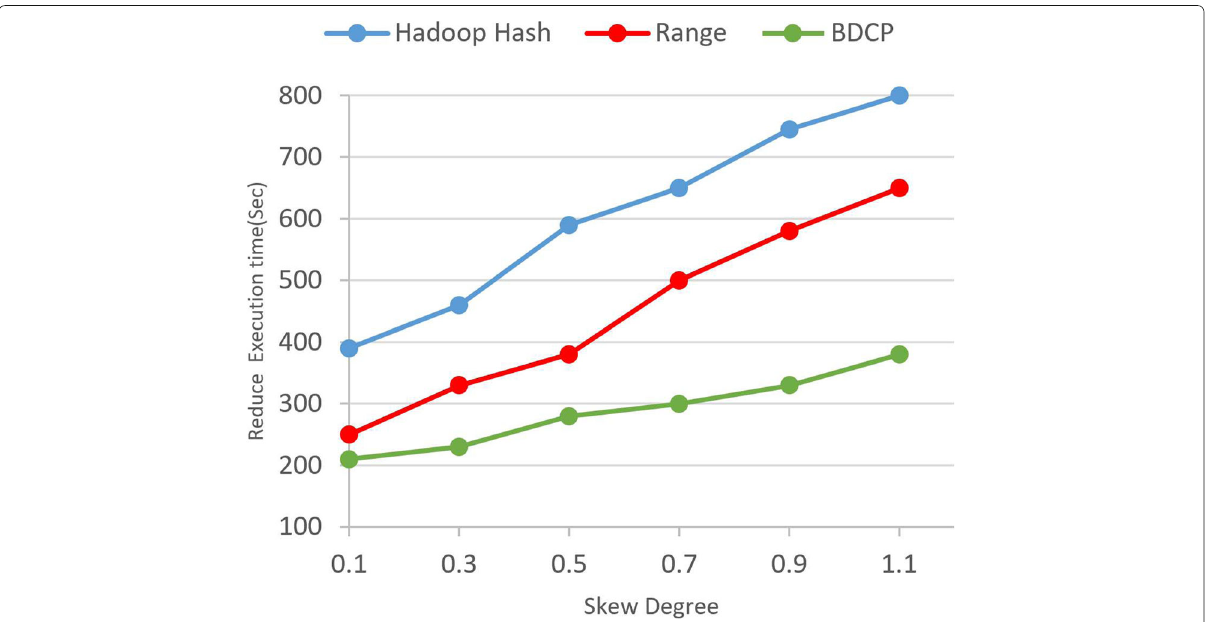
Fig. 13 Word count job on a file of size 6 GB, and 0.1 to 1.1 skew degree